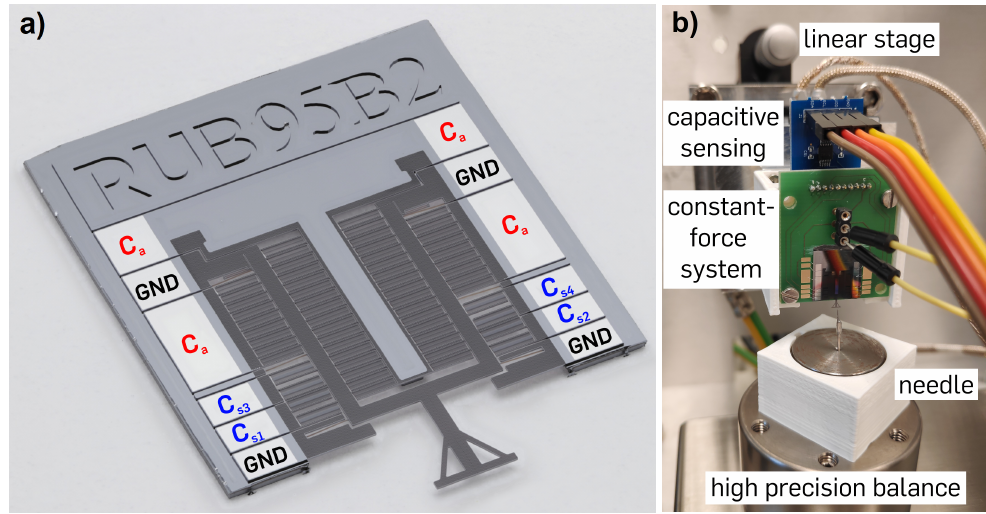
Figure 7. ( a ) Final processed constant-force microchip with electronic connections. ( b ) Experimental setup for the force measurement consists of a piezo linear stage to displace the system in y-direction and a high precision